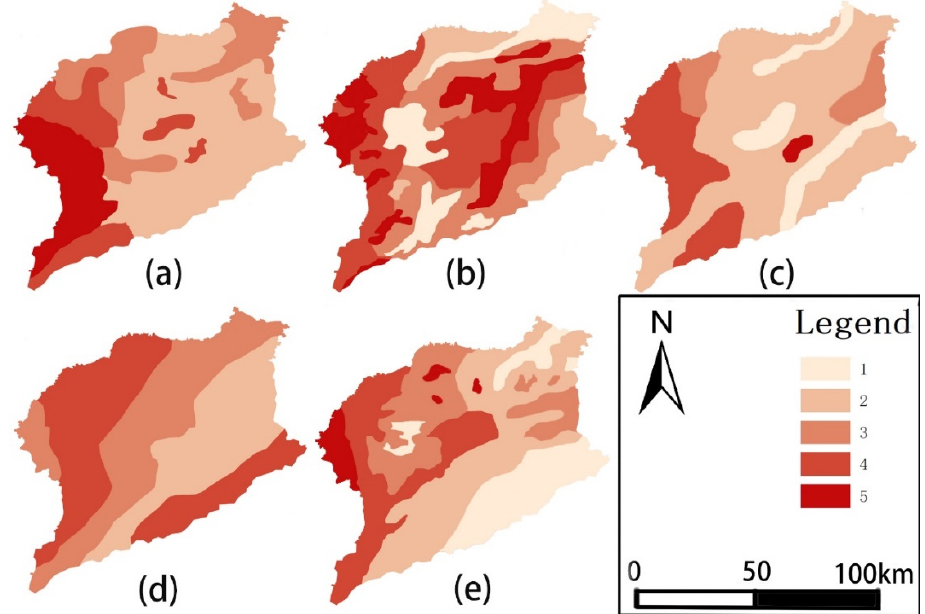
Figure 8. Maps of the five factors. ( a ) groundwater depth, ( b ) thickness of fine sand, ( c ) specific yield, ( d ) irrigation return flow, and ( e ) groundwater extraction intensity.